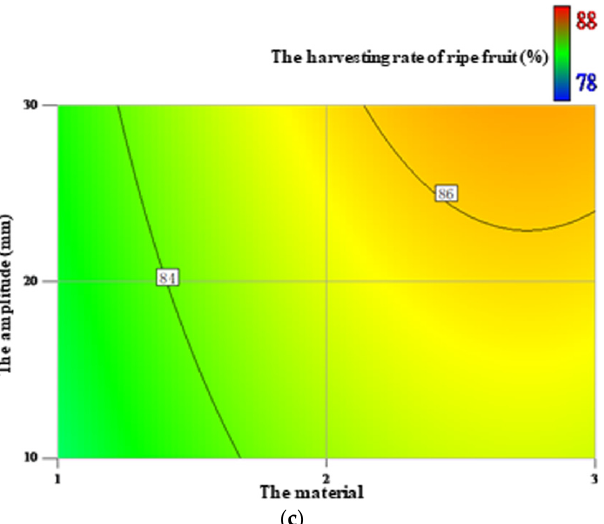
Figure 4. The response surfaces of the harvesting rate of ripe fruit affected by the rotating speed and material ( a ), the rotating speed and amplitude ( b ), and the material and amplitude ( c ). The response surfaces of the harvesting rate of unripe fruit affected by the factors are shown in Figure 5. As shown in Table 6, the rotating speed and material were equal in having the biggest effect on the harvesting rate of unripe fruit, while the amplitude had the smallest effect. The interactions between each combination of the factors did not sig- nificantly affect the harvesting rate of unripe fruit. Figure 5a shows that, as the rotating speed increased, the harvesting rate of unripe fruit initially increased slowly, but then increased rapidly at higher speeds. Similarly, as shown in Figure 5b, as the amplitude increased, the harvesting rate of unripe fruit initially increased slowly and then increased rapidly. Finally, as seen in Figure 5c, the harvesting rate of unripe fruit was highest with the polypropylene material, while the harvesting rate of unripe fruit using the wood and silica gel were nearly the same.